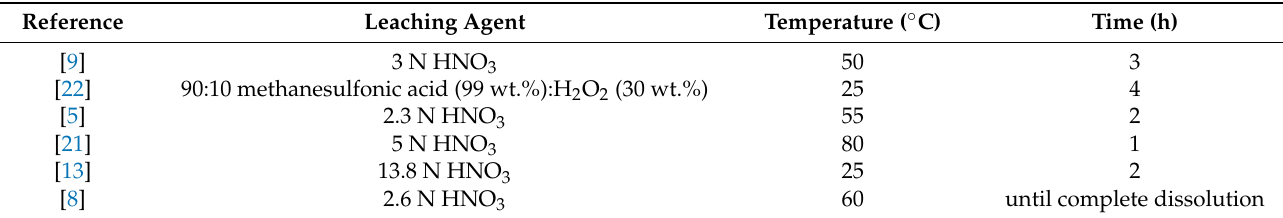
Table 1. Leaching conditions for Ag dissolution from PV